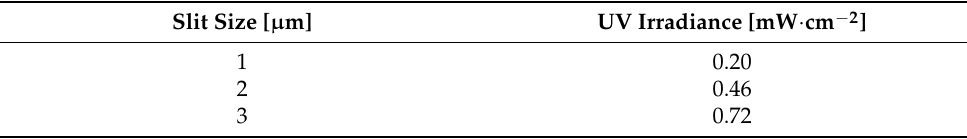
Table 1. Recalculated values of irradiation power used for degradation experiments.